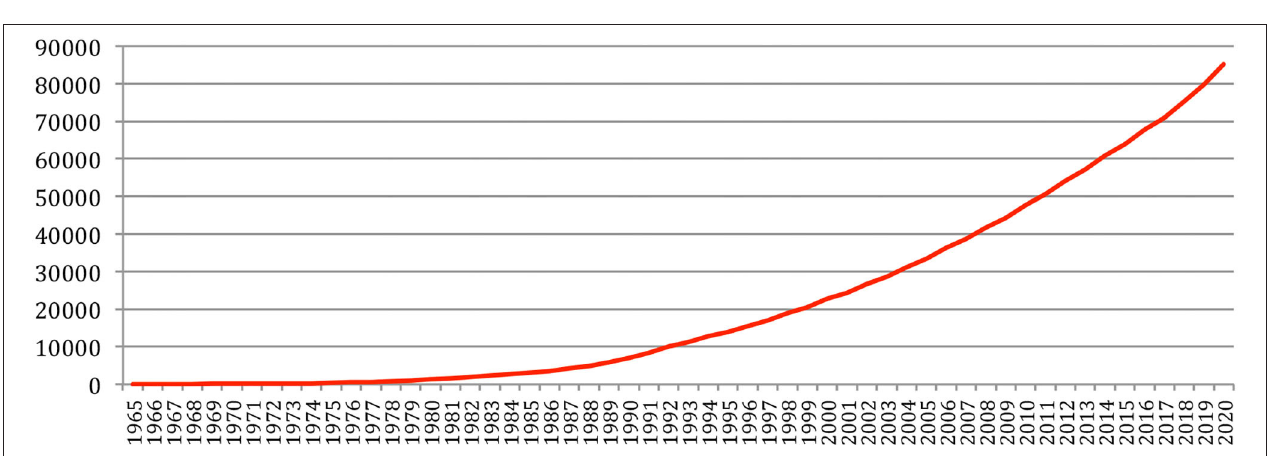
FIGURE 3 | Cumulated number of papers over the